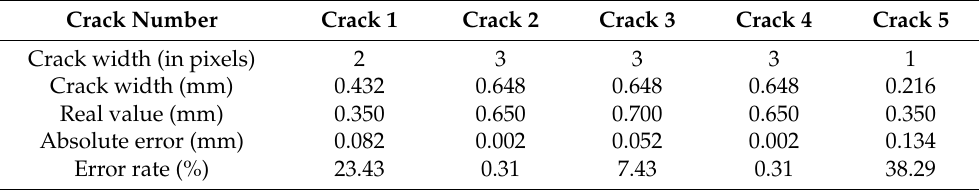
Table 7. Canny planar marking measurements (spatial resolution of one pixel: 0.216 mm).